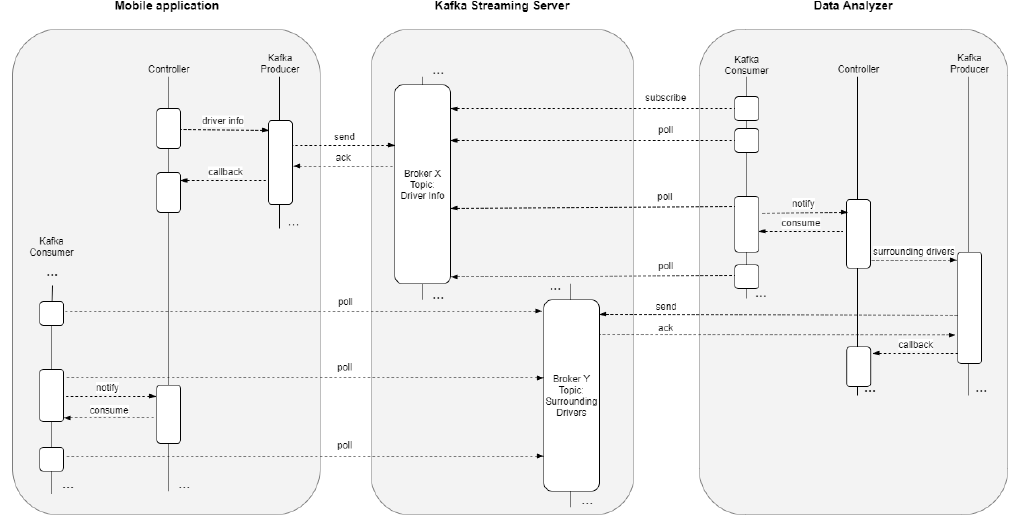
Figure 1. Data-flow diagram showing the interaction of the mobile application, Kafka streaming server and data-analyser